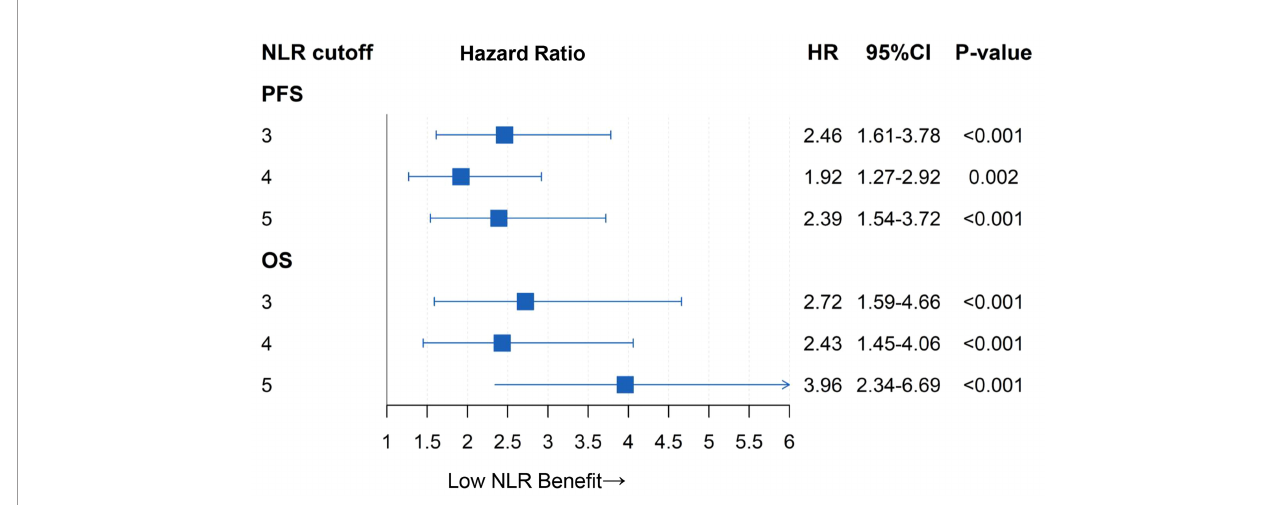
FIGURE 2 | Comparing hazard ratio between two groups using different NLR cutoff values.